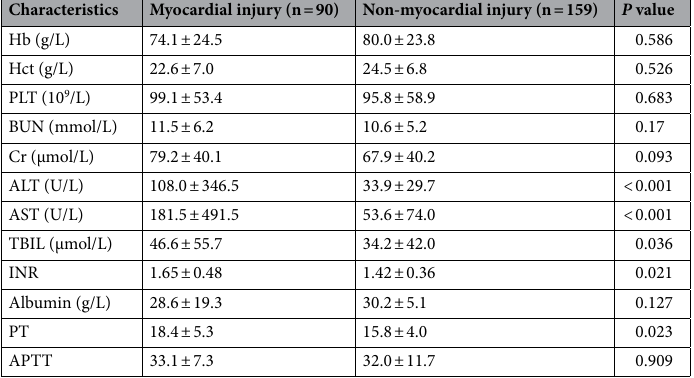
Characteristics